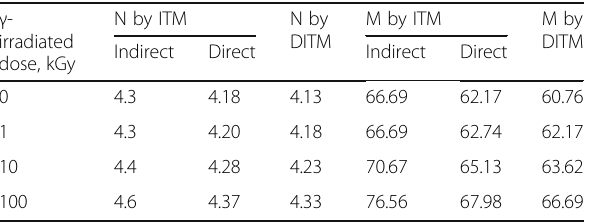
Table 2 The ( N ) and ( M ) by (ITM) and (DITM) for pristine and γ - irradiated Makrofol DE 1-1